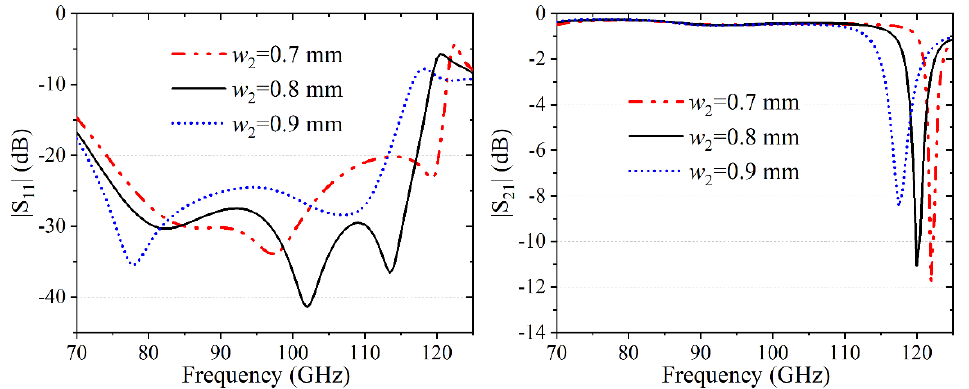
Figure 8. The simulated S-parameters with different widths of groove.